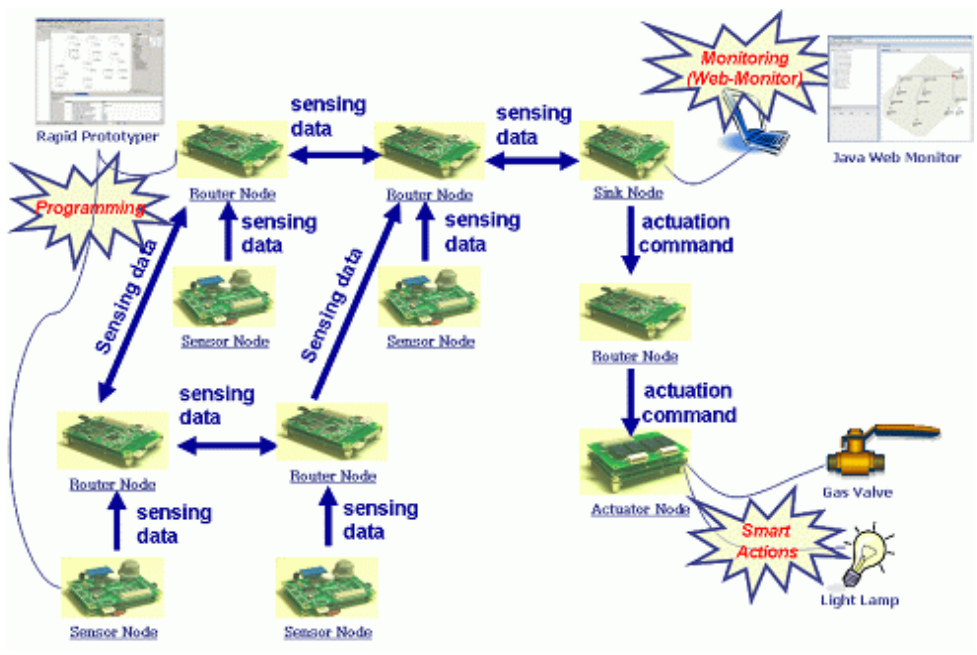
Figure 5. Structure of the G&LM